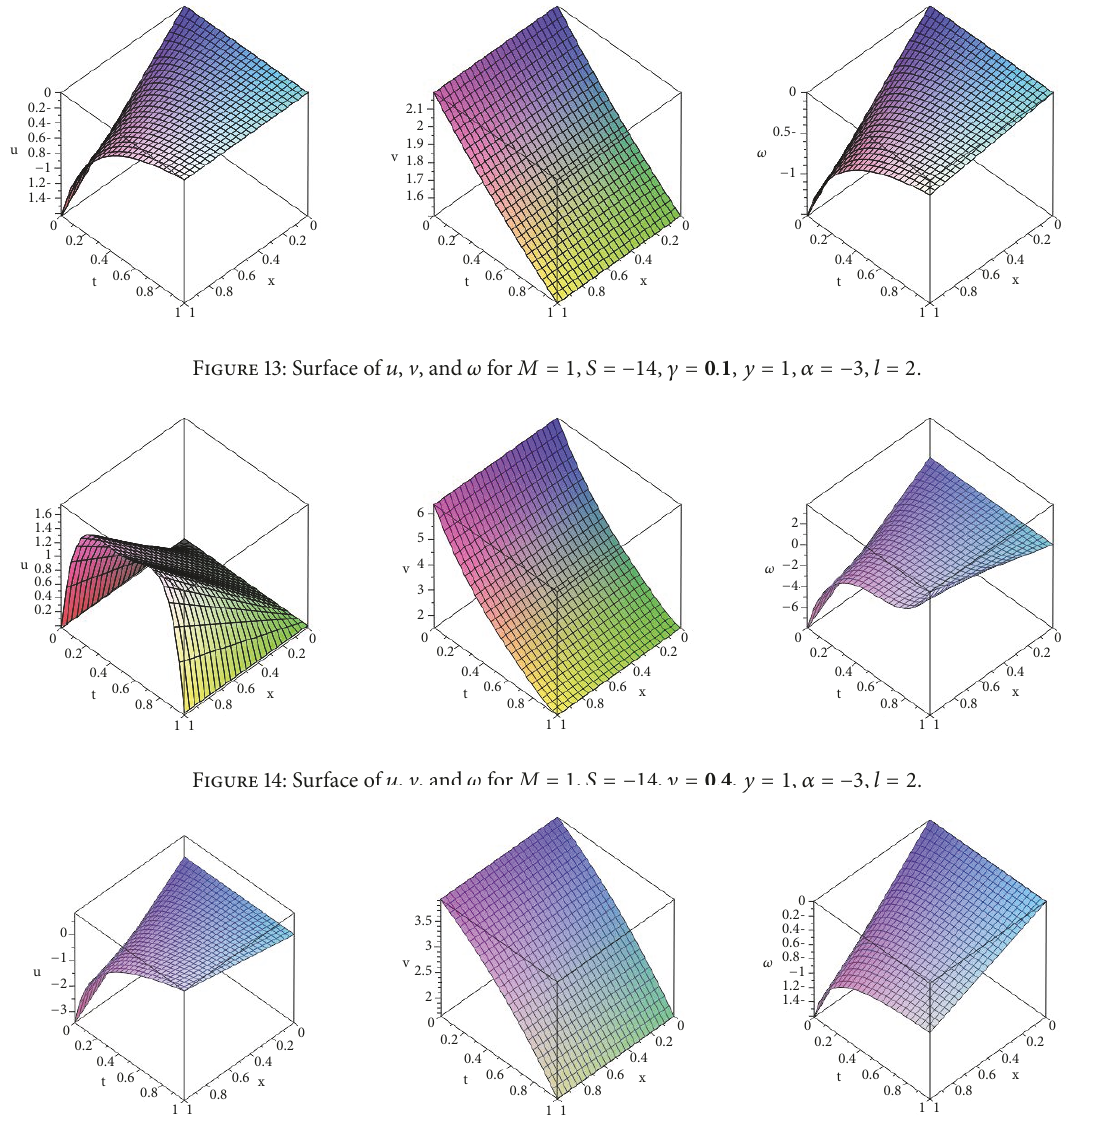
Figure 15: Surface of 𝑢 , V , and 𝜔 for 𝑀 = 1 , 𝑆 = 5 , 𝛾 = 0.5 , 𝑦 = 1 , 𝛼 = − 6 , 𝑙 = 2